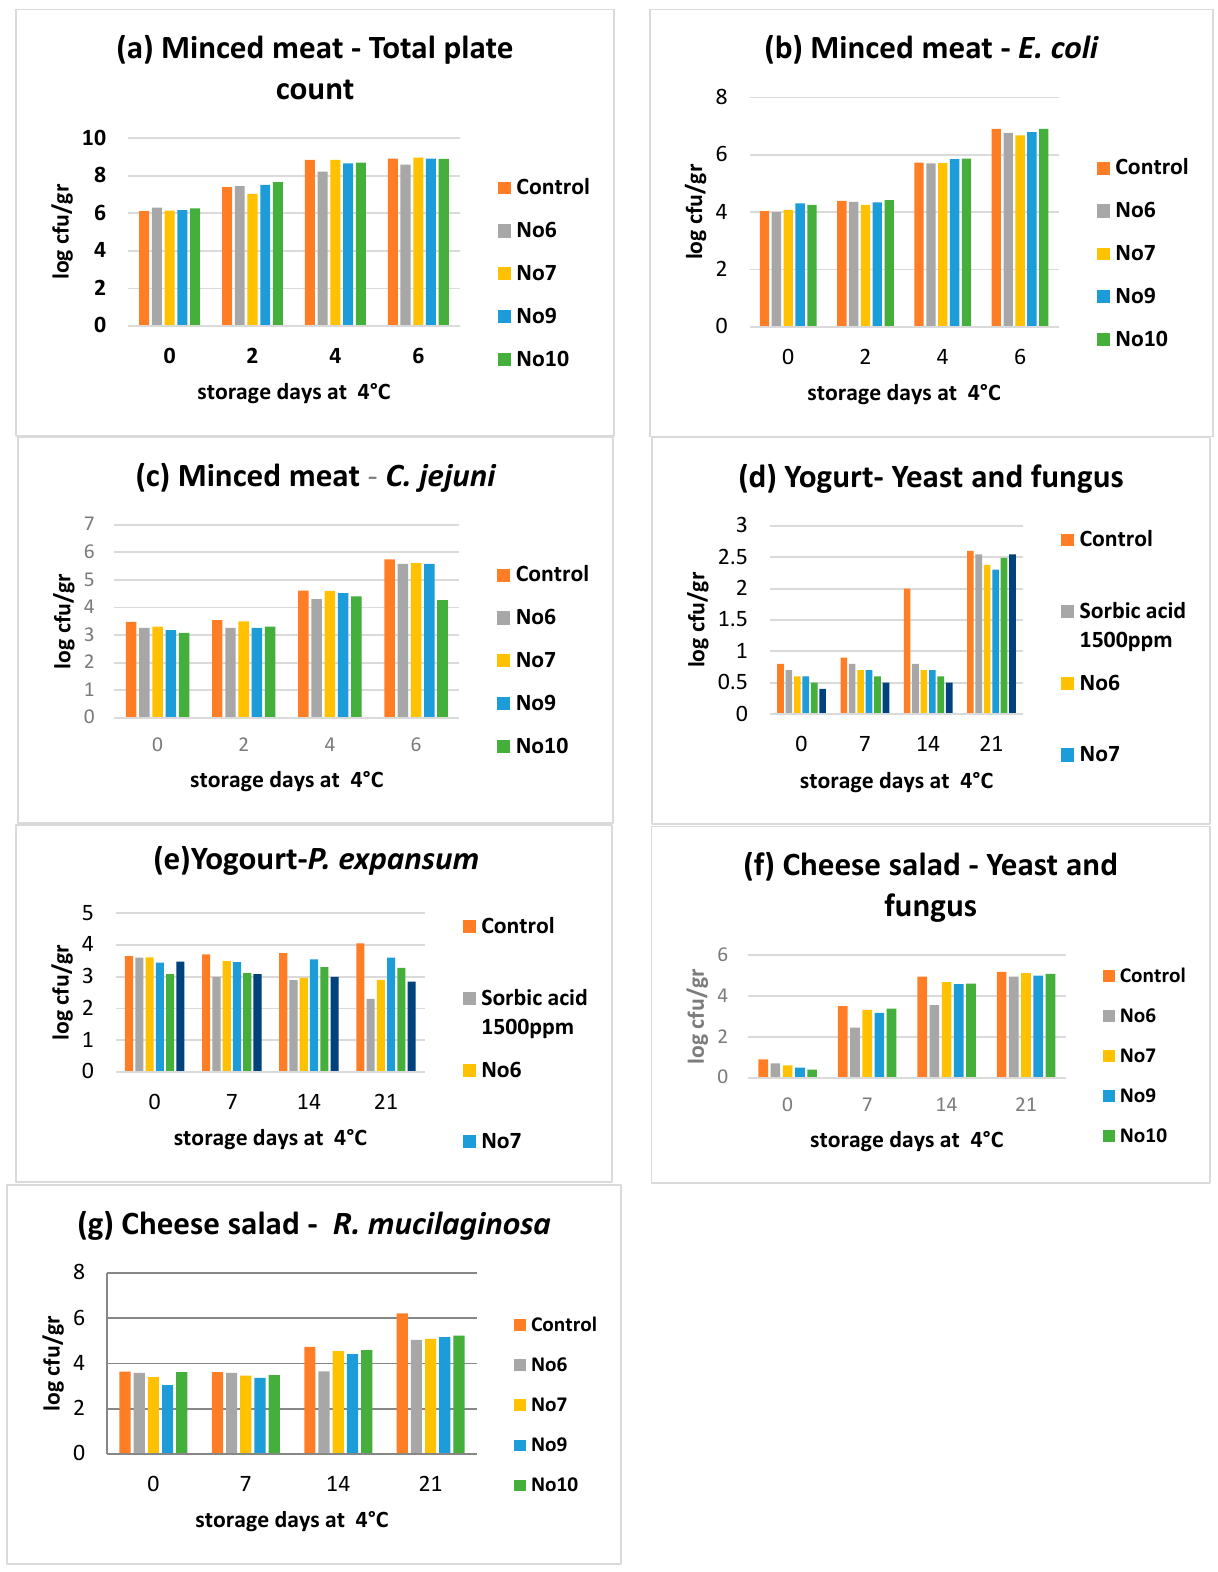
Figure 3. In vivo antimicrobial tests. ( a ), Minced meat—Total plate count; ( b ), Minced meat— E. coli ; ( c ), Minced meat— C. jejuni ; ( d ), Yogurt—Yeast and fungus; ( e ), Yogurt— P. expansum ; ( f ), Cheese salad—Yeast and fungus; ( g ), Cheese salad— R. mucilaginosa